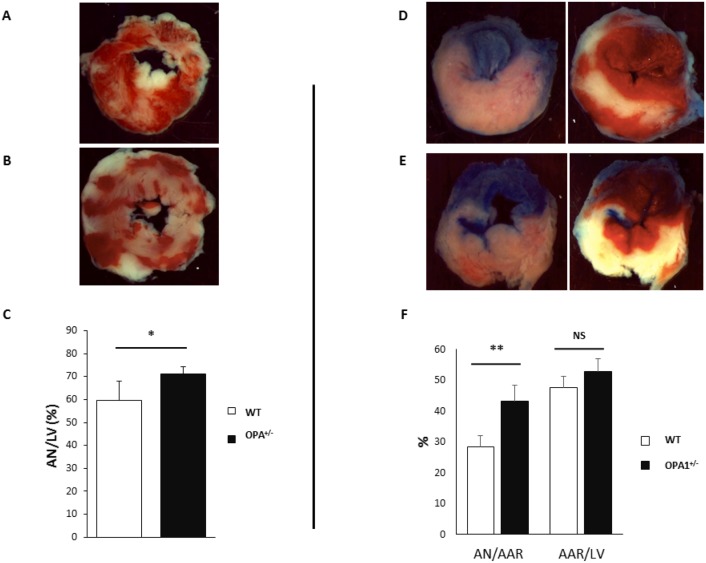
Infarct size.A, B: Examples of left-ventricular sections with TTC staining after 30 minutes of ischemia and 2 hours of reperfusion ex vivo in WT (A) and Opa1+/- (B) mice, and histograms showing AN as a percentage of total LV in WT (n = 11) and OPA1+/- (n = 12) mice (C). D, E: Examples of left-ventricular sections with TTC-staining after 45 minutes of ischemia and 2 hours of reperfusion in vivo in WT (D) and OPA1+/- (E) mice. On the left side, images before TTC staining showing Evans blue coloration of the perfused myocardium and AAR as the non-blue area. On the right side, images after TTC staining showing AN in white. F: Histograms showing AN as a percentage of AAR and AAR as a percentage of total LV area in Opa1+/- and WT mice (n = 8/group). Values are mean ± SEM. * p<0.05 and ** p<0.01. Non-parametric Mann-Whitney test (AN/AAR) and t-test (AAR/LV).